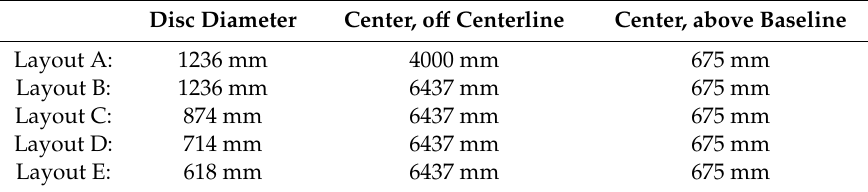
Table 4. Actuator disc